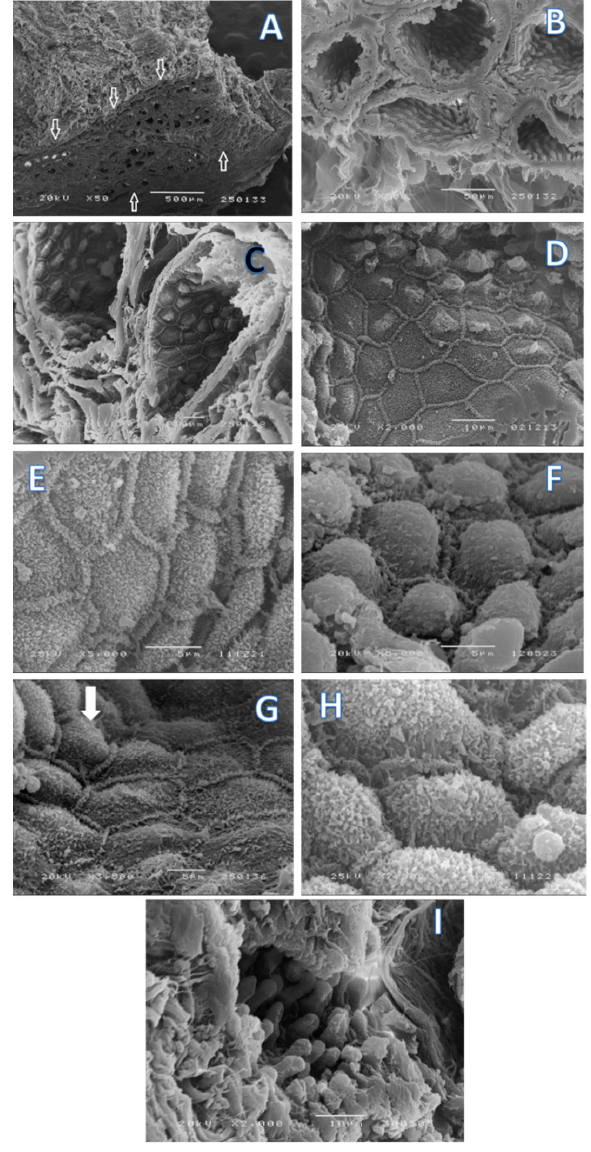
Figure 3. Scanning electronic images of IGS. In ( A ) (bar = 500 µ m); ( B ) (bar = 50 µ m) and ( C ) (bar = 10 µ m) it is clear that apocrine glandular structures appear in clusters inside the IGS.